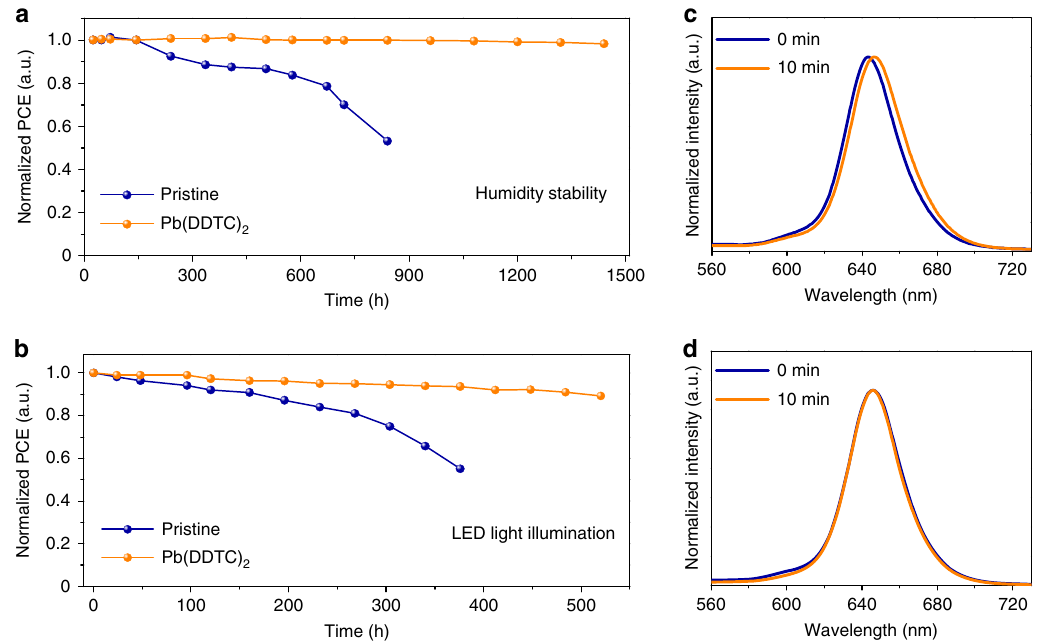
Fig. 4 Stability performance of PSCs. a Evolution of power conversion ef fi ciency of the pristine (blue) and chelated (orange) CsPbI 2 Br devices without encapsulation. The devices were stored under ambient atmosphere with controlled humidity (RH, 15 ± 3%). b Long-term stability of the pristine (blue) and chelated (orange) devices under continuous 100 mWcm − 2 white LED illumination in nitrogen glovebox. All devices con fi gurations are FTO/c-TiO 2 / perovskite/P3HT/Au. Normalized PL spectra of the ( c ) pristine and ( d ) chelated CsPbI 2 Br fi lms under continuous one sun equivalent illumination for 10 min. All perovskite fi lms were deposited on glass